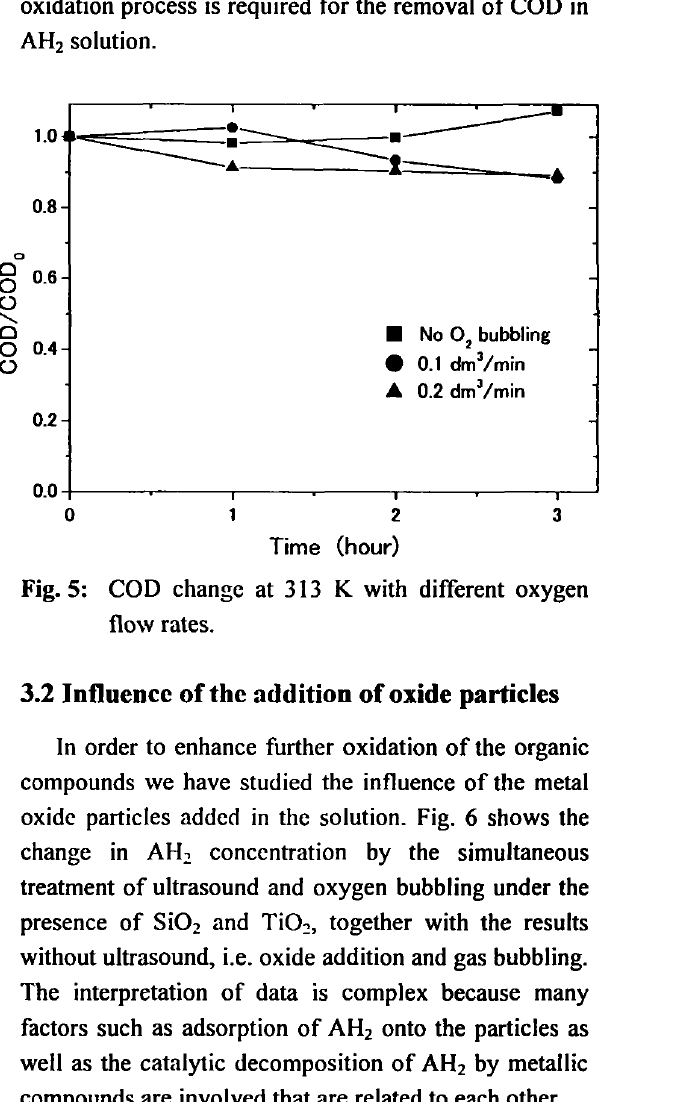
Fig. 4: Influence of oxygen flow rate on the AH decomposition at 303 K under sonication.